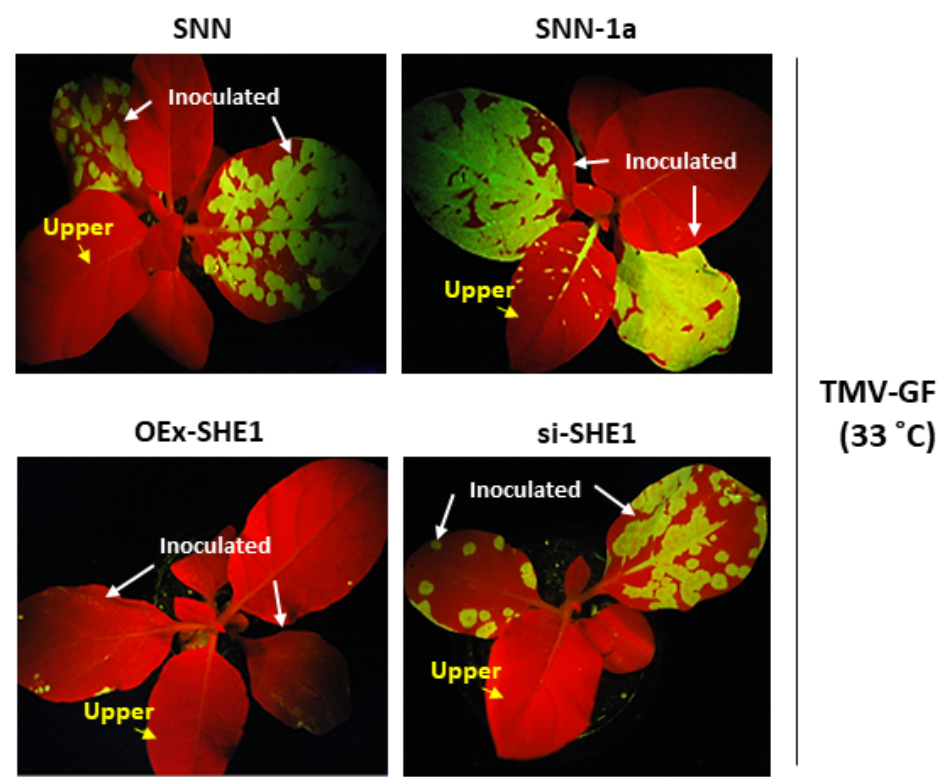
Figure 3. Effect of silencing or over-expressing SHE1, or expression of the CMV 1a protein on systemic movement of TMV-GFP at 33 ◦ C. Plants were transgenic for expression of CMV 1a (SNN-1a), overexpression of SHE1 (OEx-SHE1) or silencing of expression of SHE1 (si-SHE1). Plants were inoculated with TMV-GFP and maintained at 33 ◦ C for 2 weeks post inoculation. Whole plants were photographed under UV light. OEx-SHE1 line #5 and si-SHE1 #4 were used for the experiments. The inoculated and upper leaves are indicated by white and yellow arrows, respectively. Silencing the SHE1 gene expression also had an effect on systemic infection by WT TMV at ambient temperature, with a few lesions and other necrosis leading to leaf distortion occurring in upper leaves at later times post infection (37 dpi) (Figure 4A, right panel vs. left panel). Although asymptomatic at earlier times, the presence of TMV RNA and TMV capsid protein was confirmed by RT-PCR and Western blot analysis, respectively, in upper leaves, even at 17 dpi (Figure 4B, right panels). The data in Figures 3 and 4 suggest that the absence of SHE1 has less of an effect on the local movement of either WT TMV or TMV-GFP, but rather allowed a slow systemic infection by WT TMV to